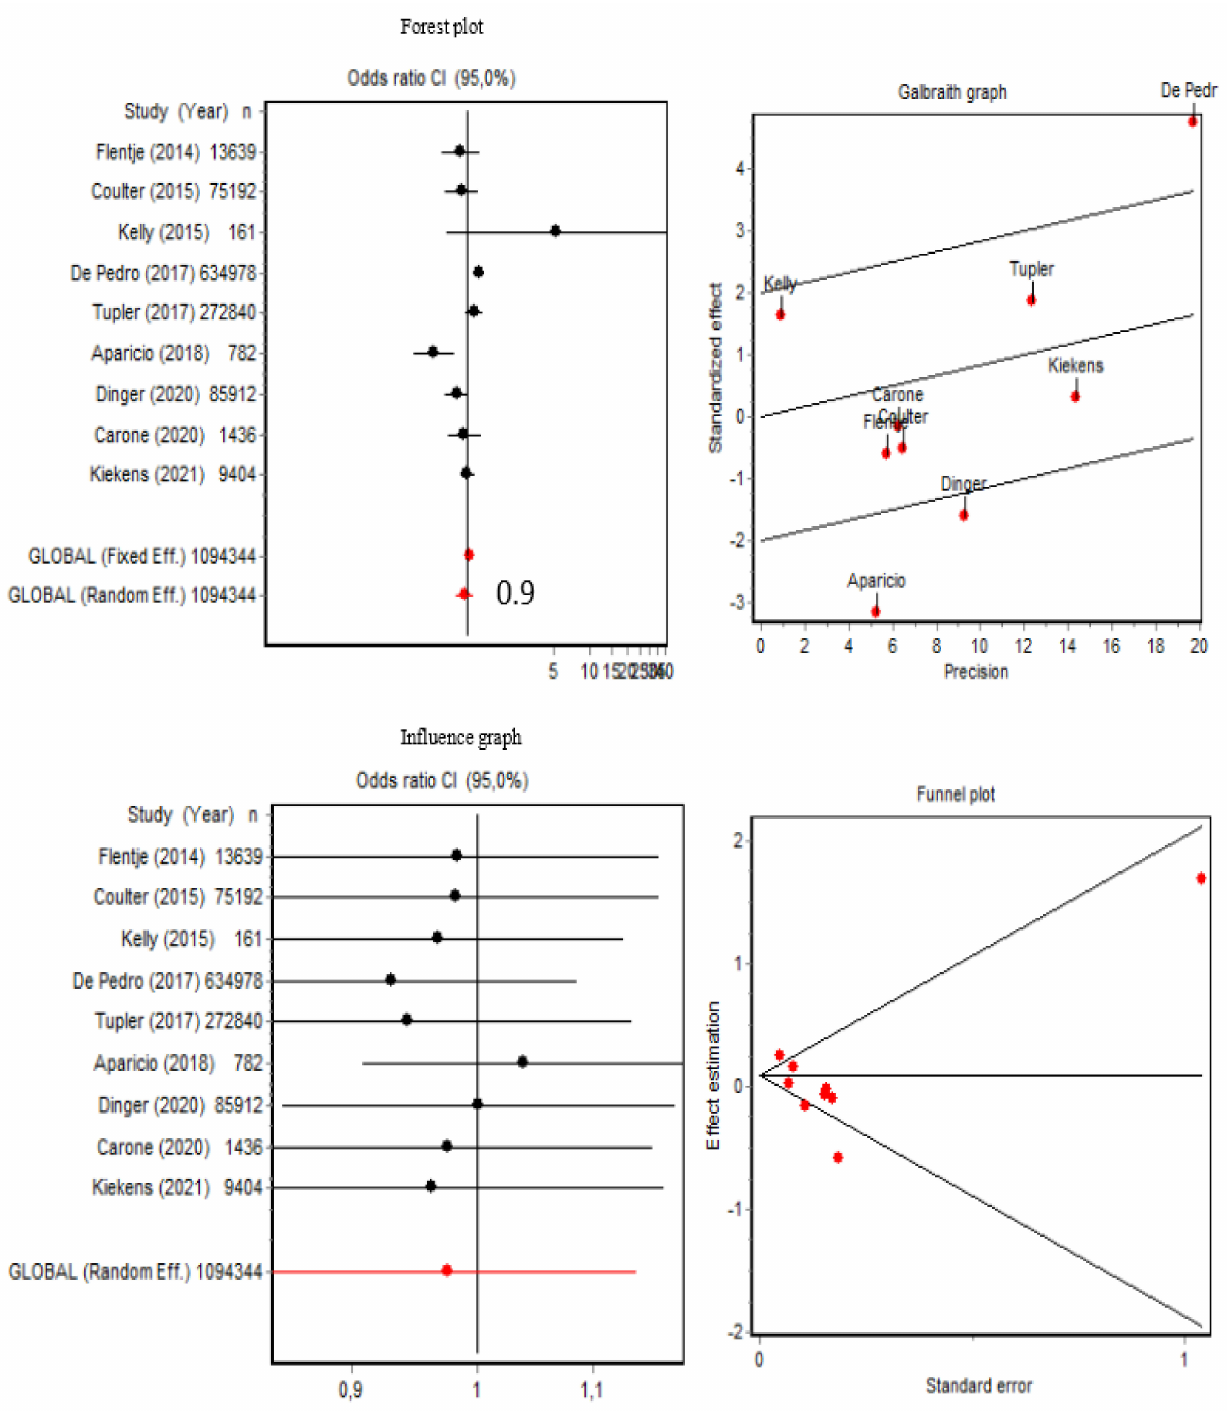
Figure 3. Forest plot, Galbraith graphic, influence graphic, and funnel plot for current alcohol